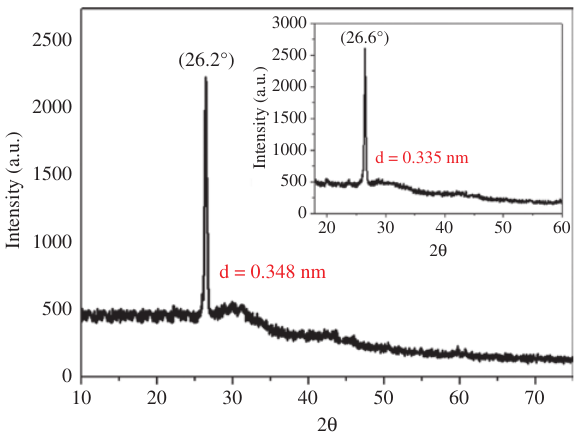
Figure 5: XRD pattern of as-prepared graphene flakes.